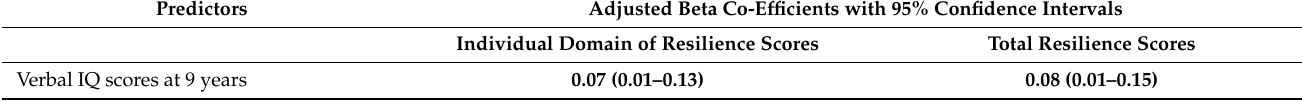
Table 3. Multivariate analysis of individual and total domains of resilience scores at 9 years with concurrent cognition and early childhood factors in MAL-ED cohort ( n = 204